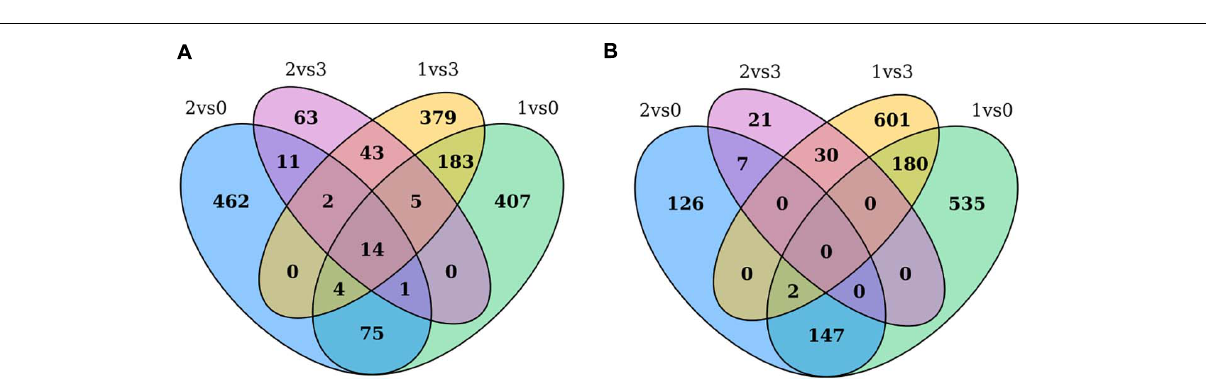
FIGURE 7 | Gene expression profile between pairwise comparisons. Venn diagram showed the number of DEGs in different treatments. (A) Up-regulated DEGs between cold treated and incubators cultured were also among the genes differentially expressed between cold treated and 1 cm control. (B) Down-regulated DEGs between cold treated and incubators cultured were also among the genes differentially expressed between cold treated and 1 cm